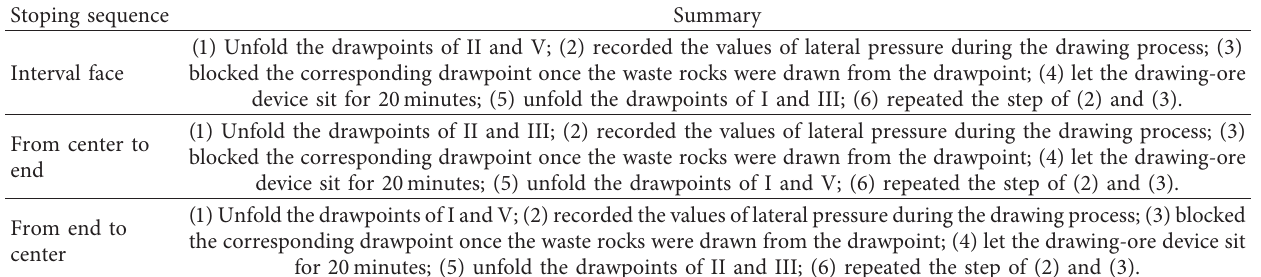
Table 4: Summary of stoping sequence.